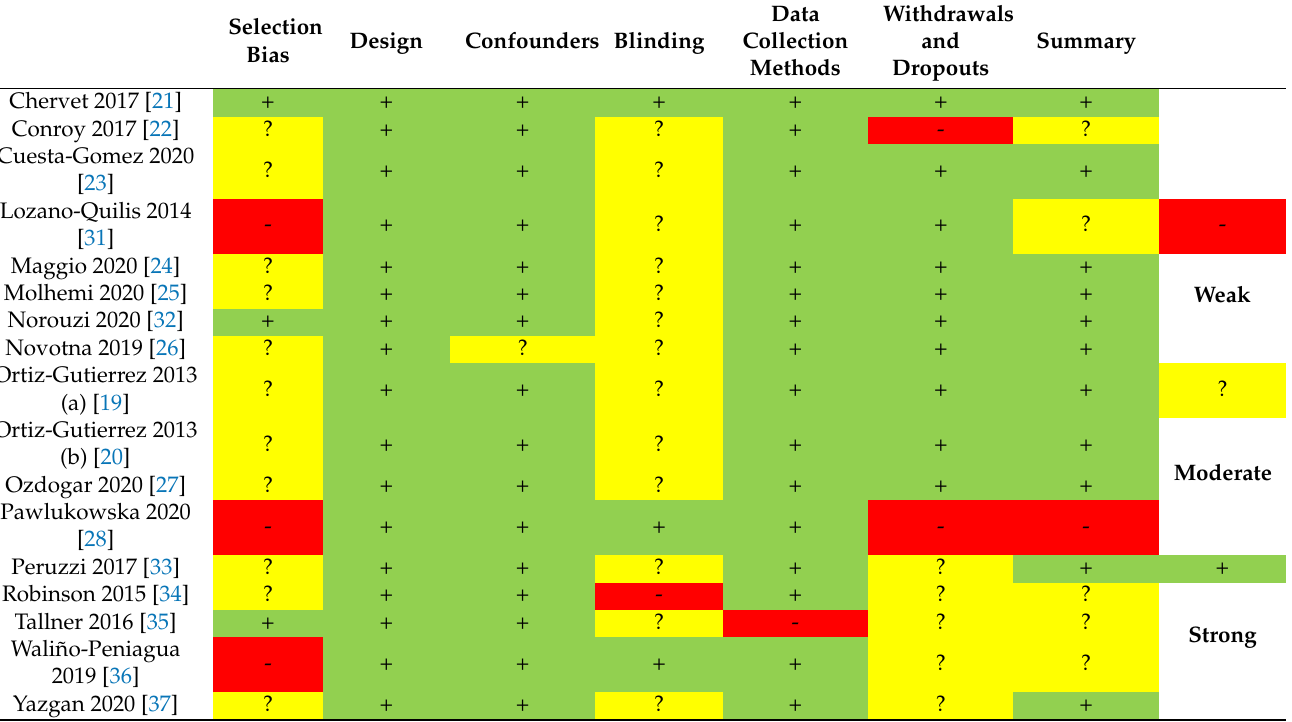
Table 1. Evaluation of the methodological quality of each study using QATQS. Selection